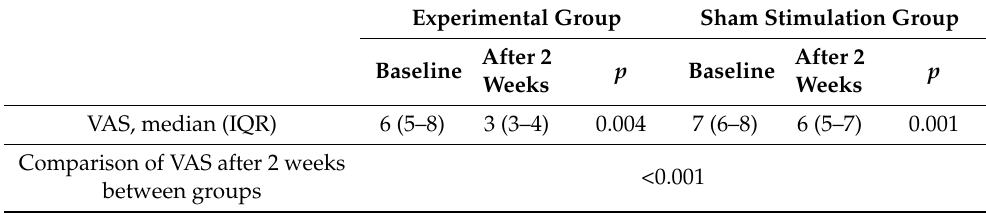
Table 2. Comparison of VAS score before and after treatment between two groups.